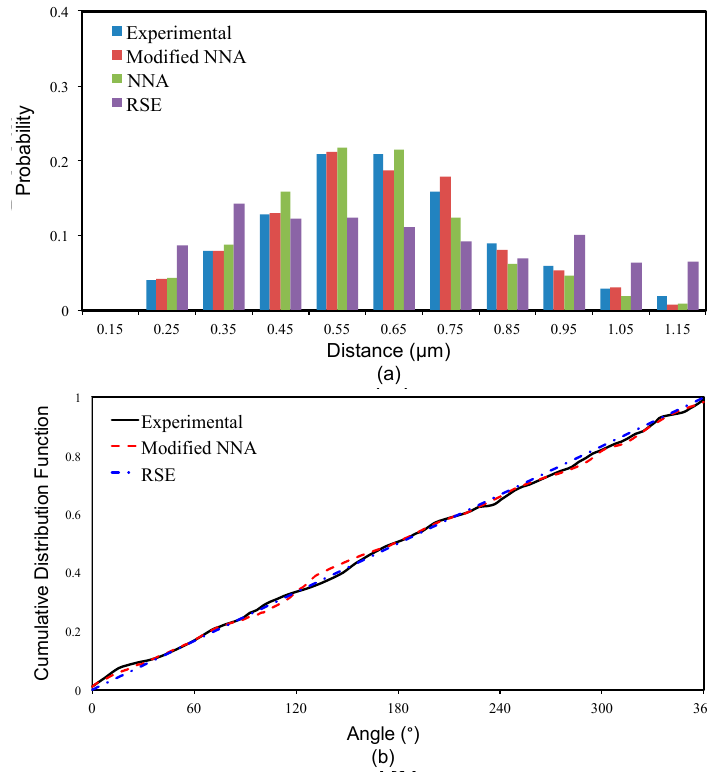
Figure 4. Comparison of experimental measured and computational modeled ( a ) probability density function of nearest neighbor distances and ( b ) cumulative distribution function of nearest neighbor